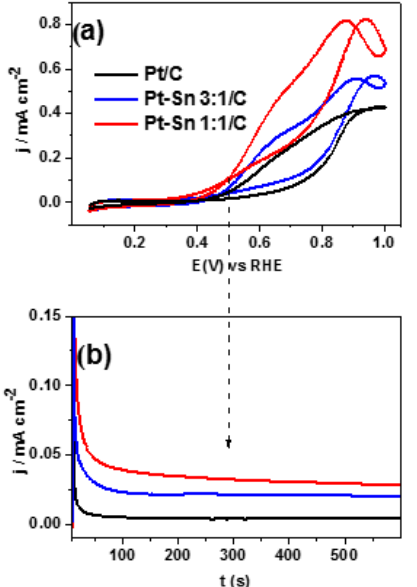
Figure 3. Ethanol electrooxidation on Pt/C, Pt–Sn 3:1/C and Pt–Sn 1:1/C catalysts in 1 M CH 3 CH 2 OH + 0.5 M H 2 SO 4 at room temperature. ( a ) CVs recorded at 0.02 V·s − 1 ; ( b ) current-transients recorded at 0.5 V.